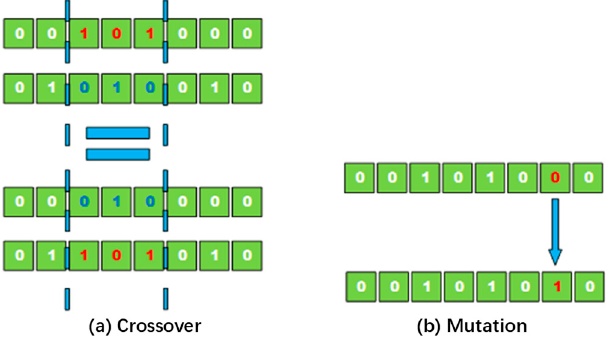
Figure 8. GA operators. ( a ) Crossover; ( b ) Mutation.